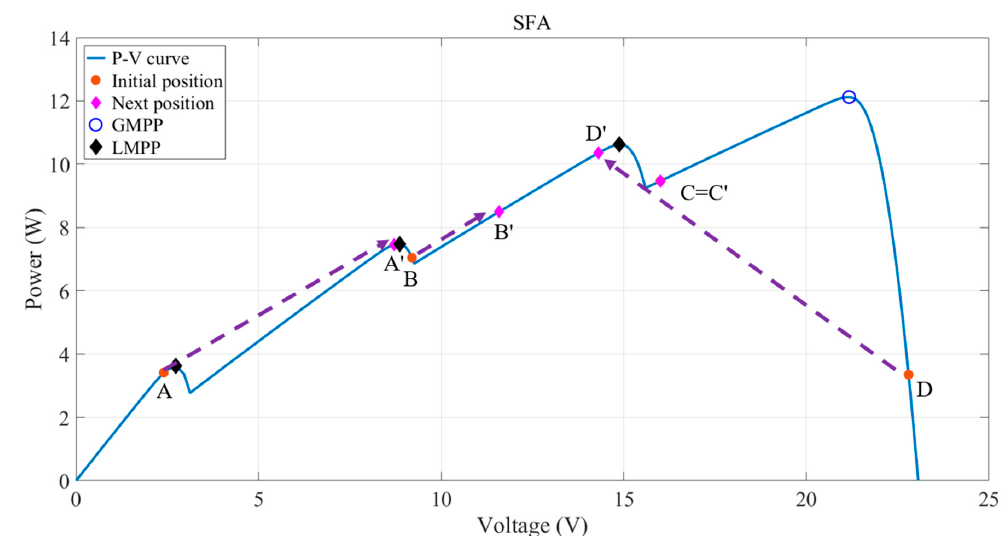
Figure 5. Adjustment of operating points along the P - V curve of a PV array under PSCs with the simplified firefly algorithm (SFA).